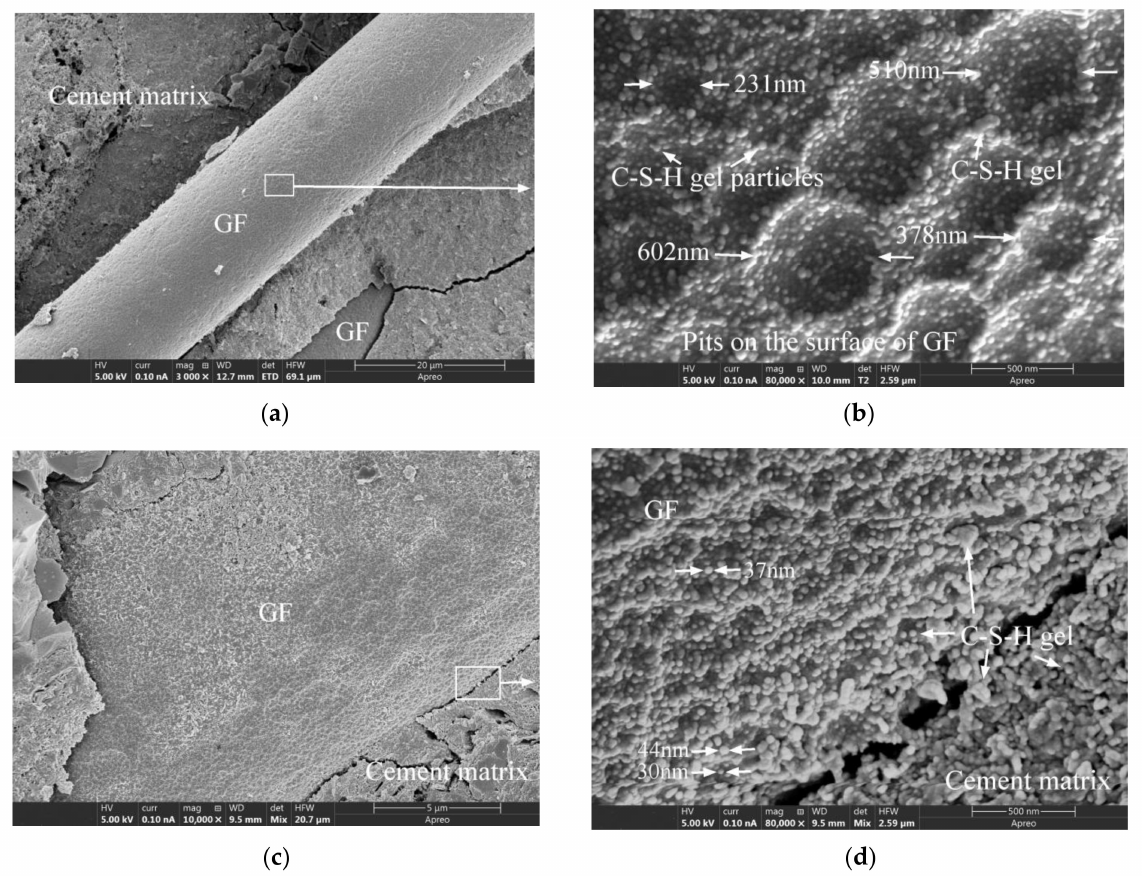
Figure 10. The SEM images of GFRC specimens: ( a ) GF-35-45; ( b ) GF-35-45; ( c ) GF-35-90; ( d ) GF-35-90. Figure 10a,c present the GF morphologies of specimens GF-35-45 and GF-35-90, it